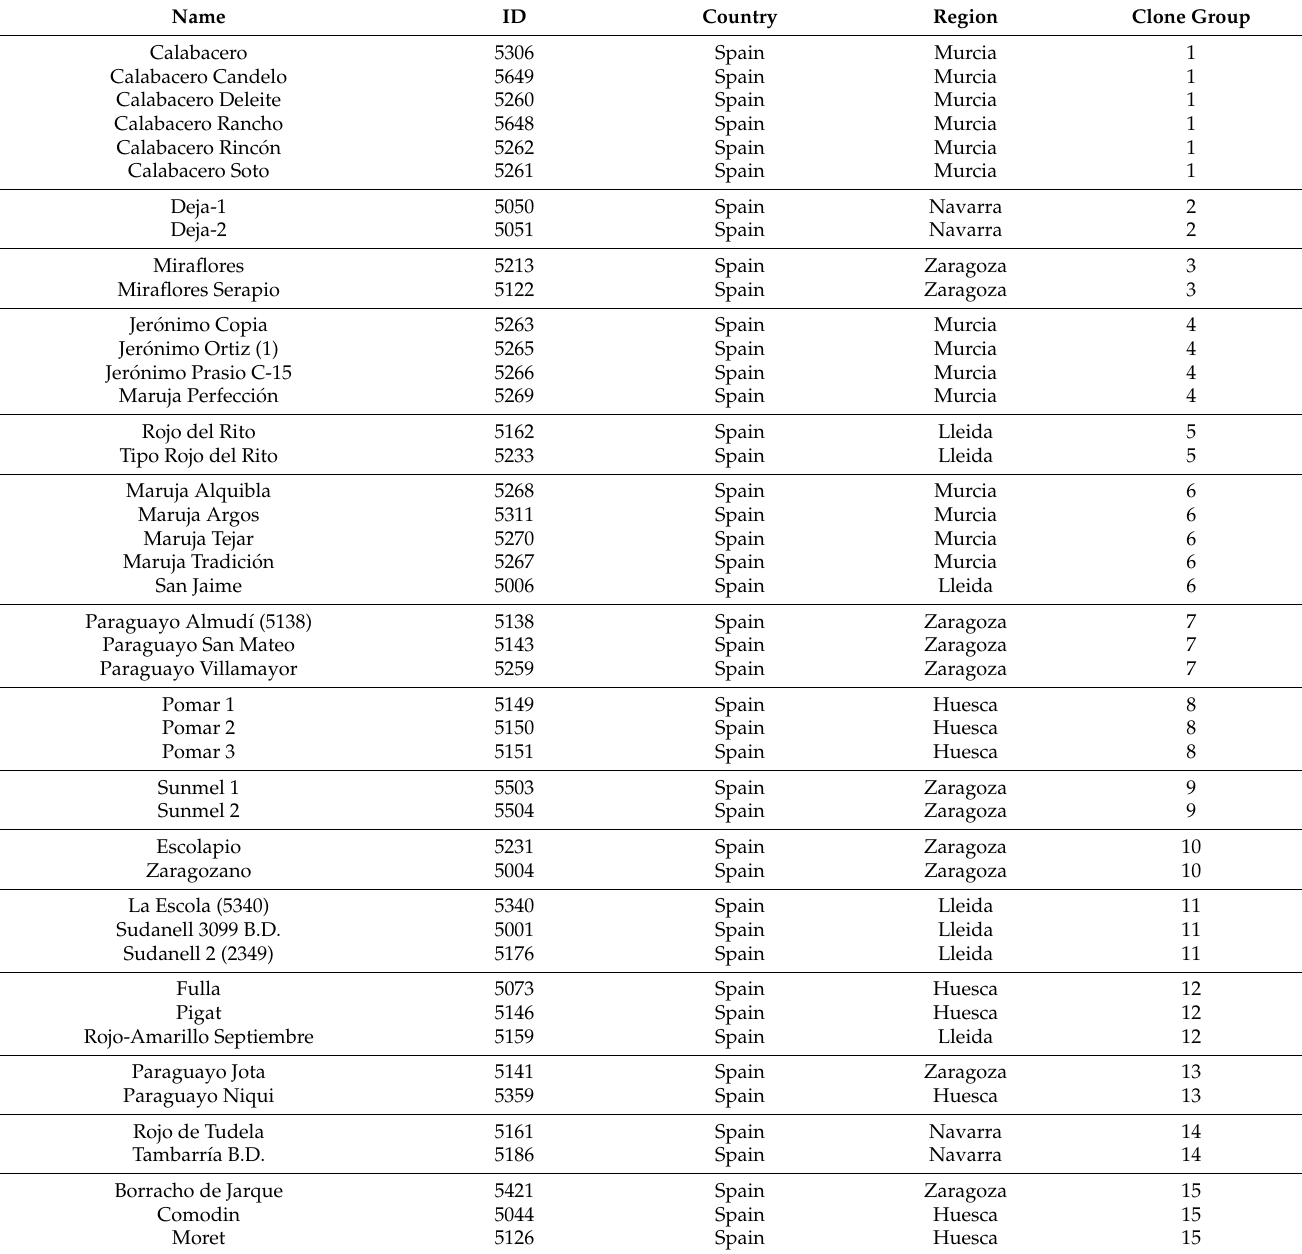
Table 2. Clones detected through Identity-By-Descent (IBD) analysis in